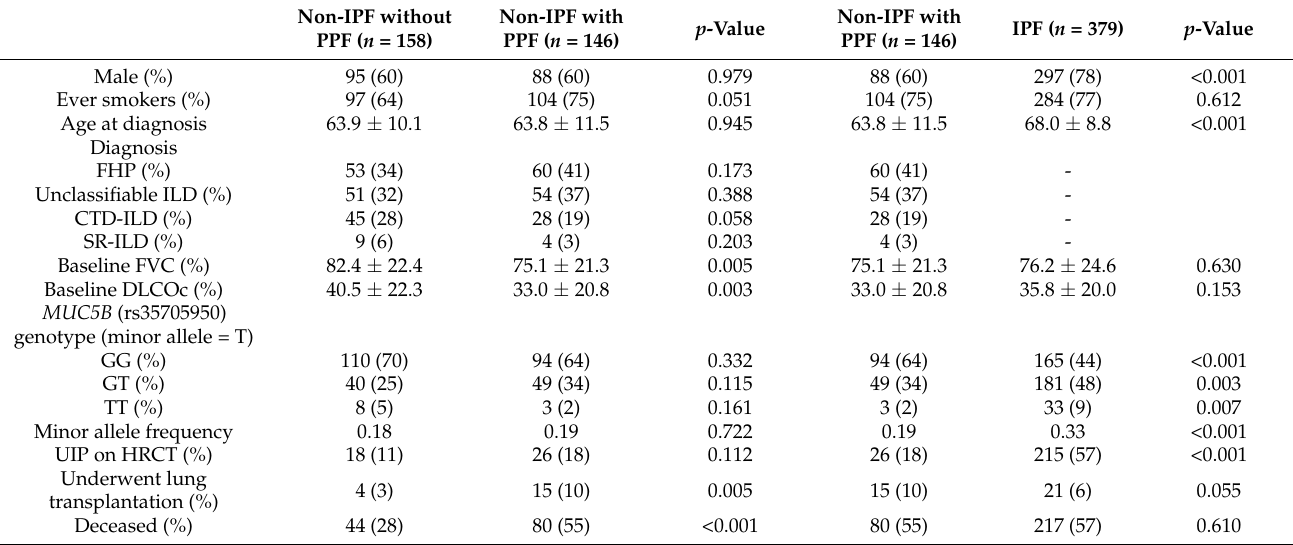
Table 1. Baseline characteristics of the study population divided into non-IPF without PPF, with PPF and IPF.